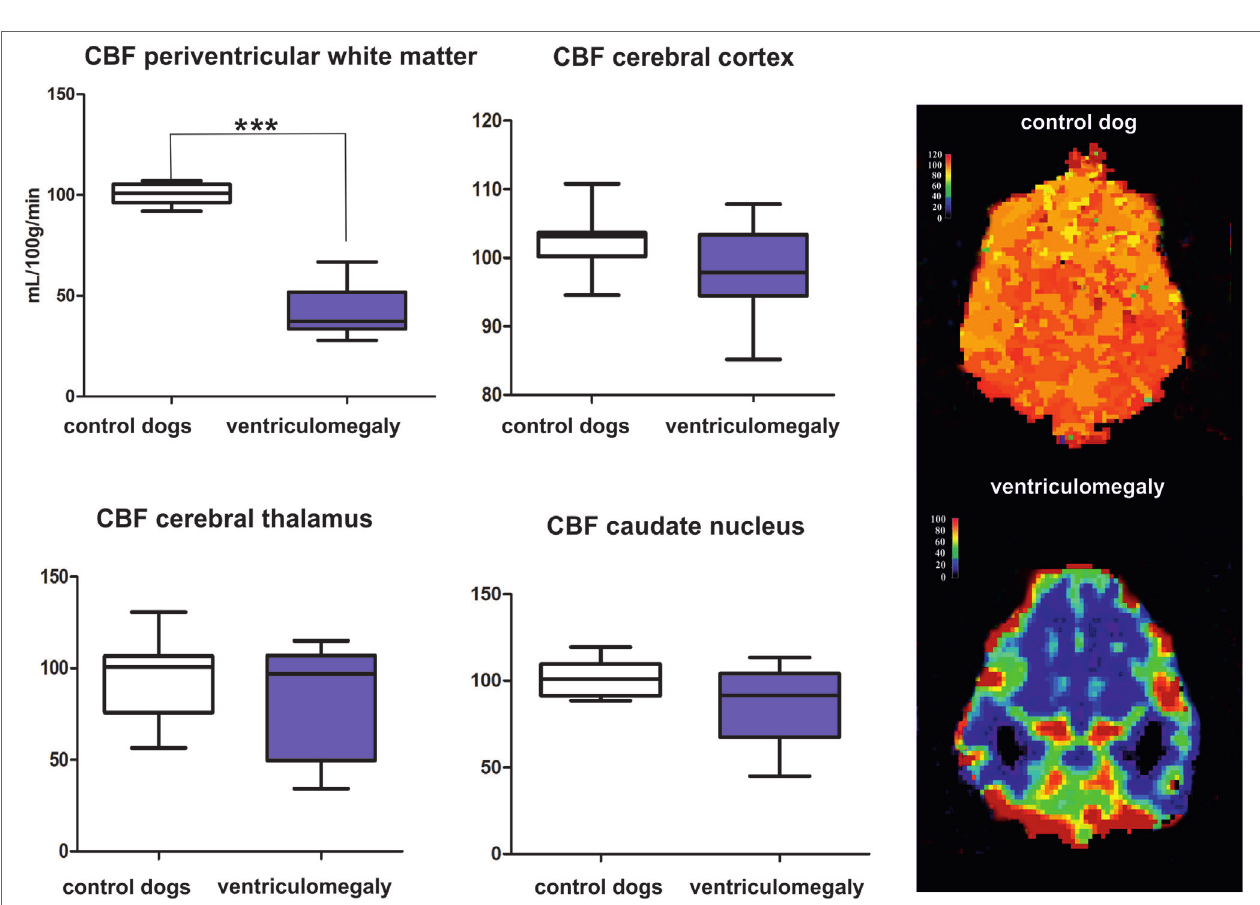
FigUre 2 | Results of the group comparison of cerebral blood flow (CBF) between Cavalier King Charles spaniels (CKCS) with and without ventriculomegaly. Results presented as mean, range, 25, and 75 quartile in a box and whisker plot. Significantly different parameters are marked with asterisks (*** p < 0.001). Color-coded perfusion maps are displayed for CBF values in a normal CKCS and in a Cavalier King Charles spaniel with